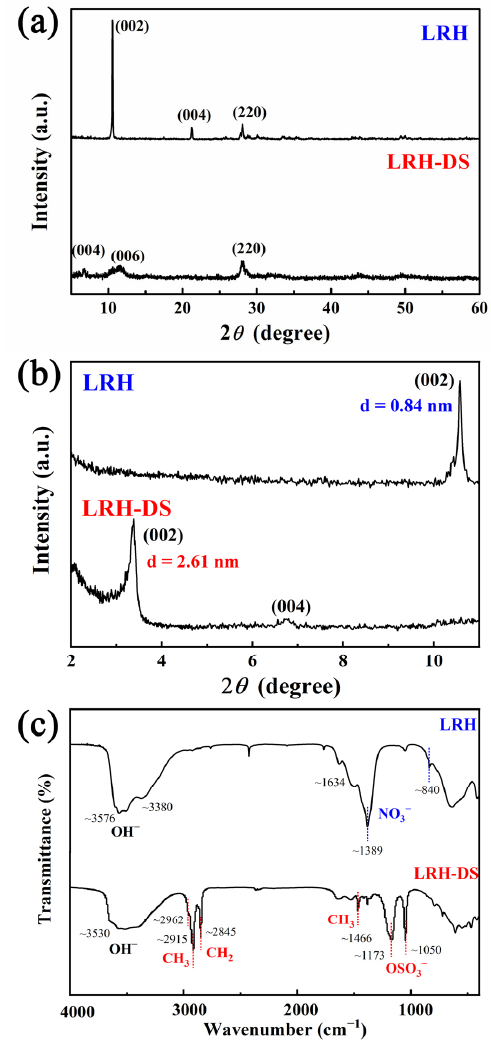
Figure 1. ( a , b ) XRD patterns and ( c ) FT-IR spectra for layered rare-earth hydroxide (LRH) and anion-exchanged product LRH-DS.